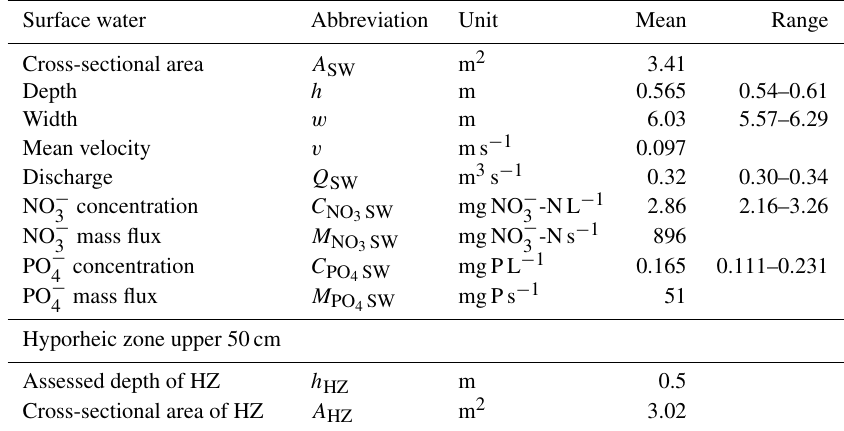
Table 2. Selected morphological and hydrological parameters of the testing site for the duration of the testing phase from 4–11 June 2015. Ranges are indicated for directly measured parameters, the remaining parameters have been calculated from listed means. HZ: hyporheic